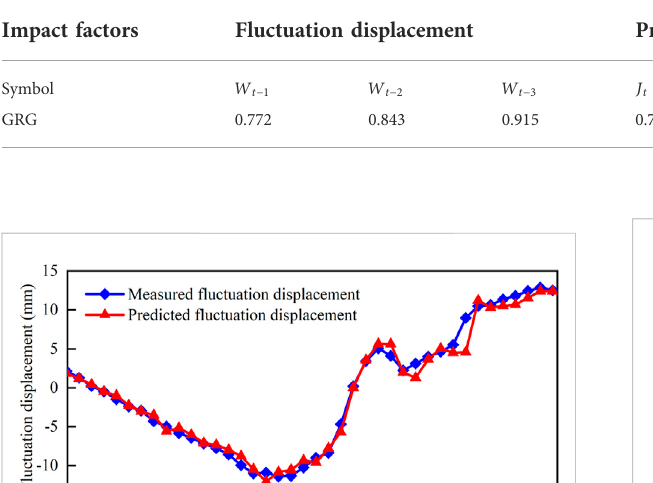
TABLE 2 Grey relational degree (GRG) between each impact factor and fl uctuation displacement.